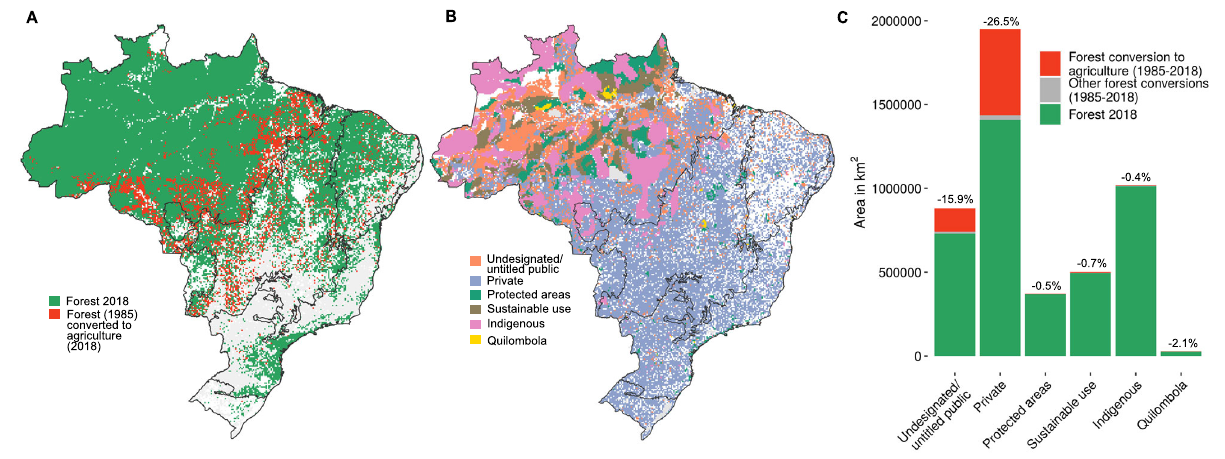
C Shows totalareas of forestthat were convertedto agriculture(red) orother land uses (gray) between 1985 and 2018, and remaining forest cover in 2018 (green), across all Brazil-wide parcels under each tenure regime. Percentages of total ori- ginal (1985) forest cover per tenure regime that were converted to agriculture by 2018 are indicated above each